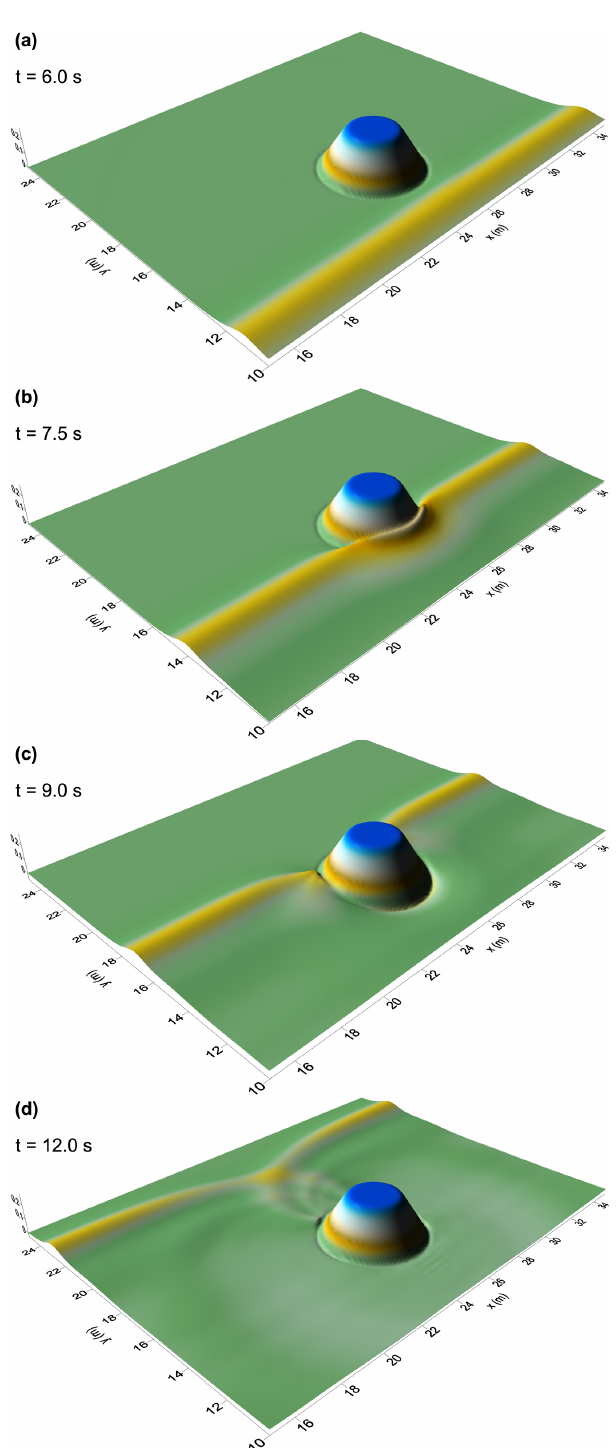
Figure 3. Tsunami run-up on a circular island: snapshots of the free surface for the experiment with ε = 0 . 20 at: (a) t = 6 . 0s, (b) t = 7 . 5s, (c) t = 9 . 0s, and (d) t = 12 .